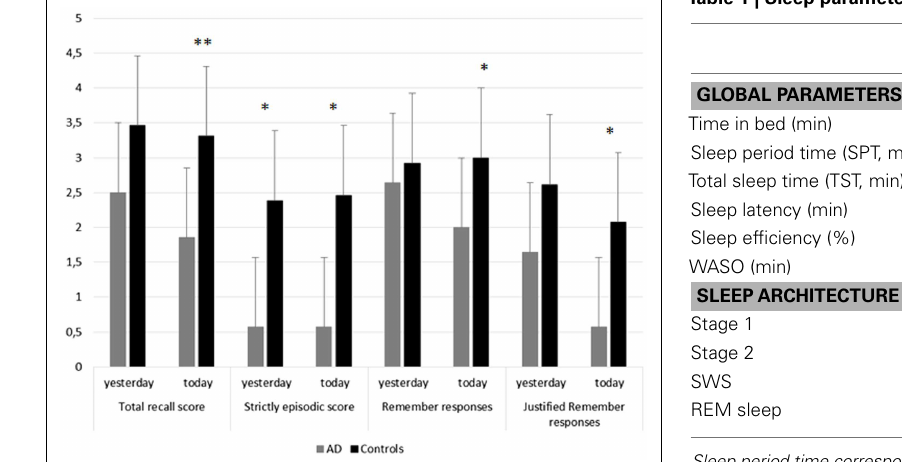
Table 1 | Sleep parameters inAD patients and controls.